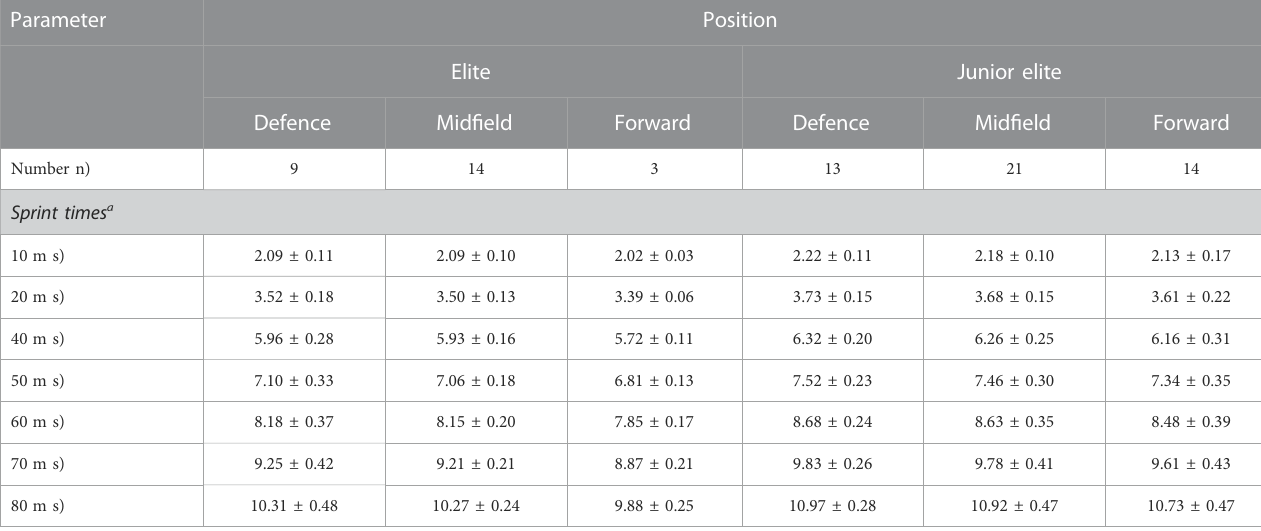
TABLE 2 Mean (±SD) sprint times at the different distances for each playing position and level. Parameter Position Elite Junior elite Defence Mid fi eld Forward